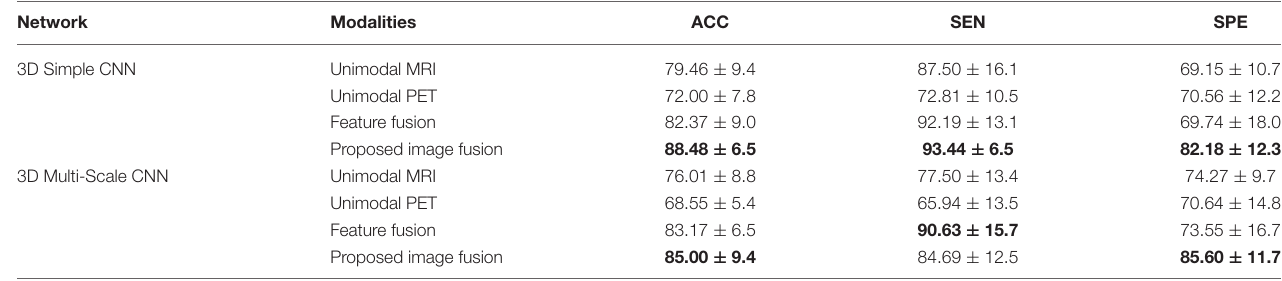
TABLE 3 | Results of different modalities with different networks for MCI vs. NC (UNIT:%). Network